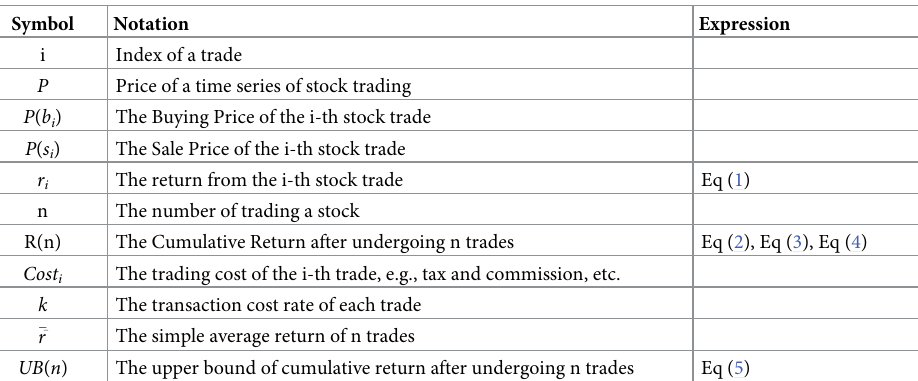
Table 1. Symbols and